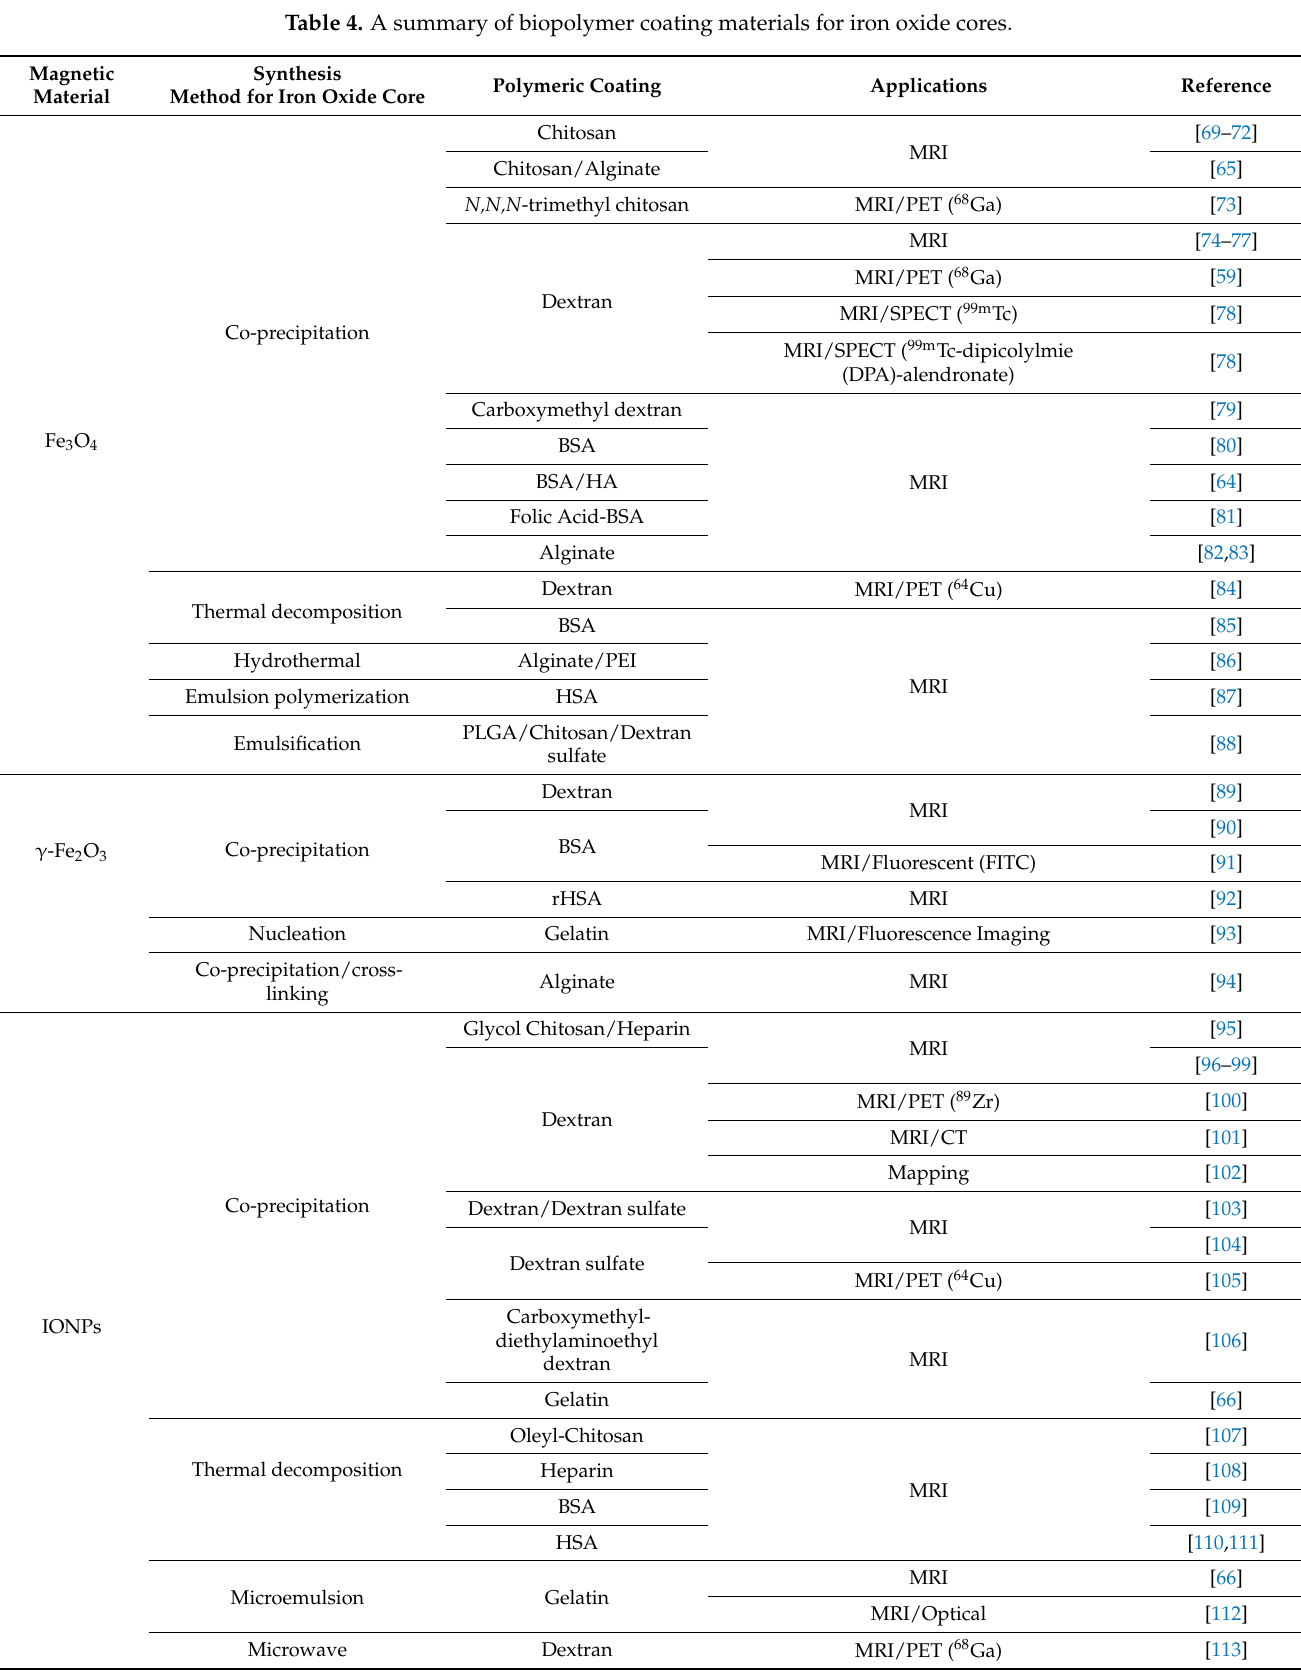
Table 4. A summary of biopolymer coating materials for iron oxide